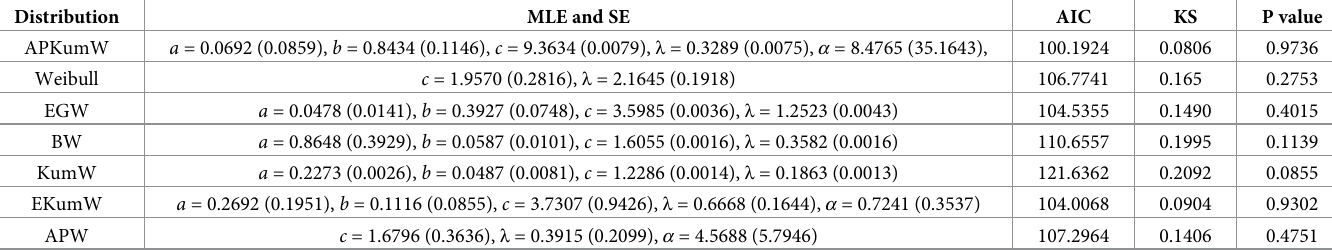
Table 6. MLEs, (SEs) for the parameters and associated goodness of fit statistics for the bladder cancer I data.